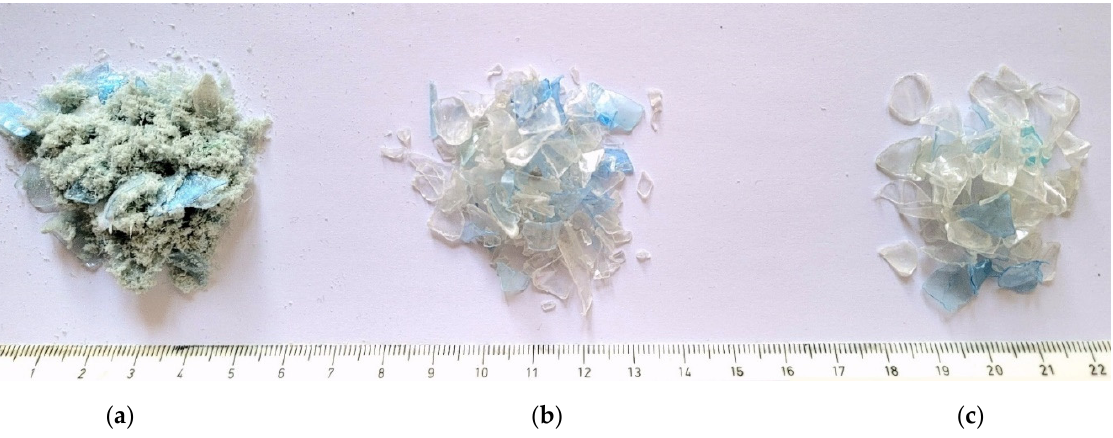
Figure 1. PET bottle recycling products: ( a ) PET fines waste/powder—manufacturing waste, ( b ) washed PET fines of fraction 0.5–4.0 mm—non-quality product, and ( c ) washed PET Fines of fraction 4.0–12.0 mm—quality product.